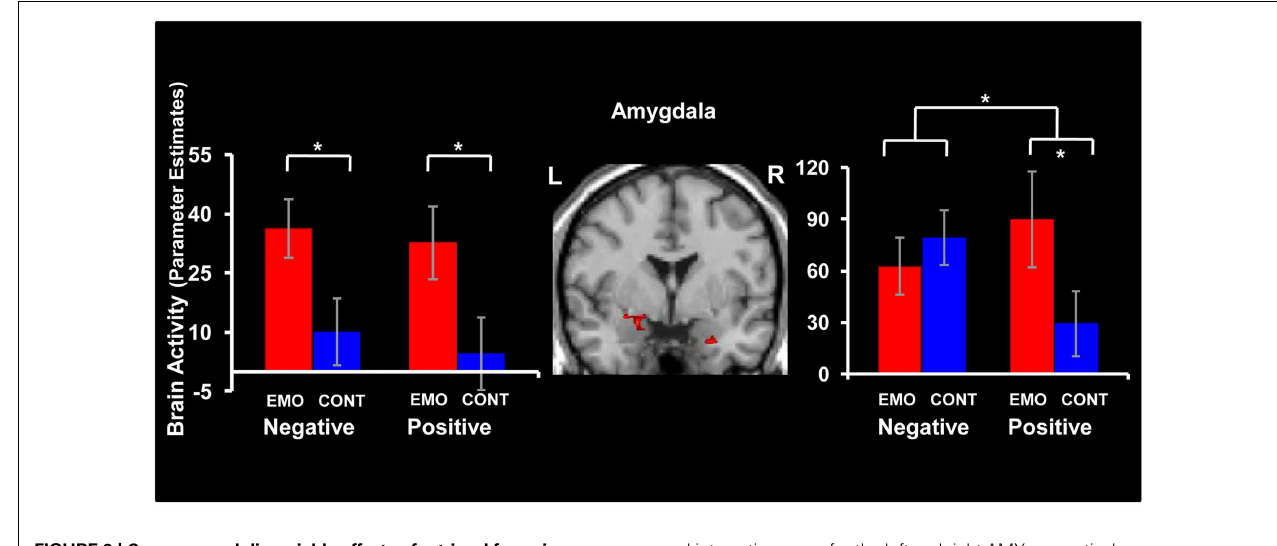
FIGURE 3 | Common and dissociable effects of retrieval focus in the amygdala (AMY), for positive and negative memories . Focusing on Emotion (EMO) compared to focusing on Context (CONT) led to similar increases of activity in the left AMY (left panel) for both positive and negative memories; dissociable patterns of activity linked to valence were observed in the right AMY (right panel).The conjunction